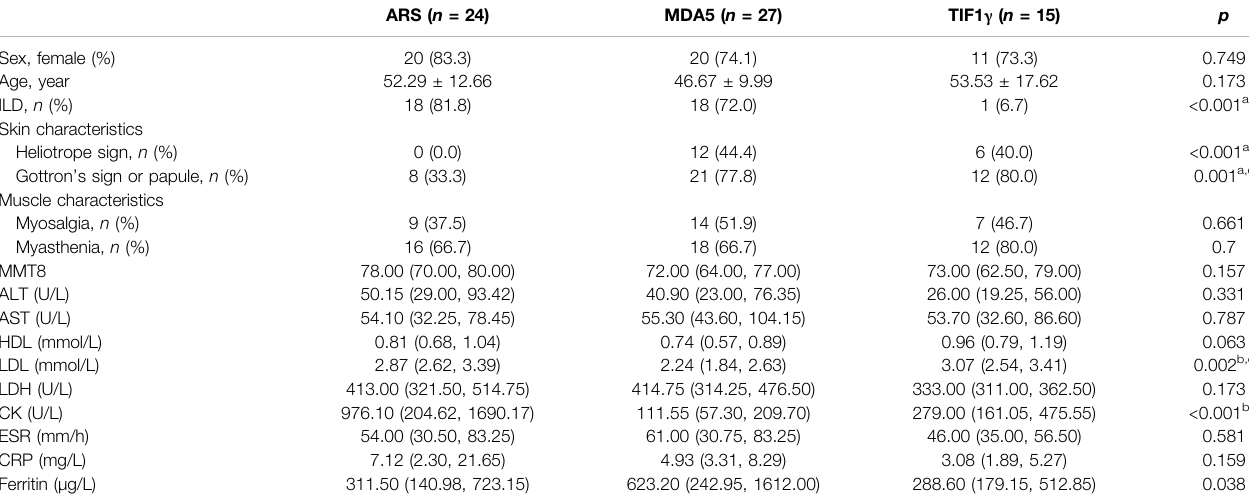
TABLE 2 | Comparison of clinical information among anti-ARS positive, anti-MDA5 positive and anti-TIF1 γ positive untreated IIMs patients. ARS ( n = 24) MDA5 ( n = 27) TIF1 γ ( n = 15) p Sex, female